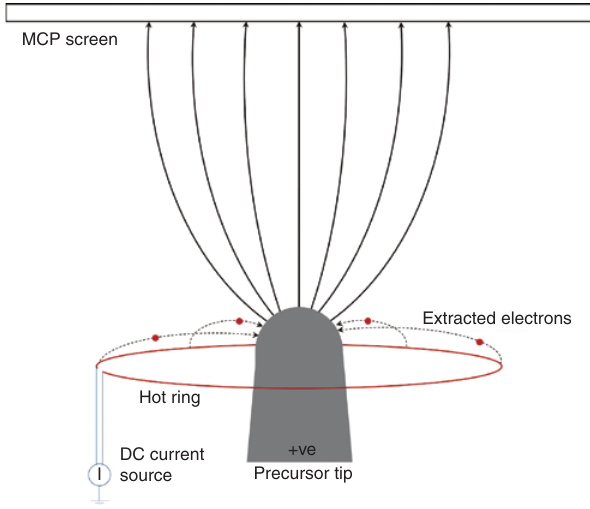
Figure 2: Schematic for the local electron bombardment